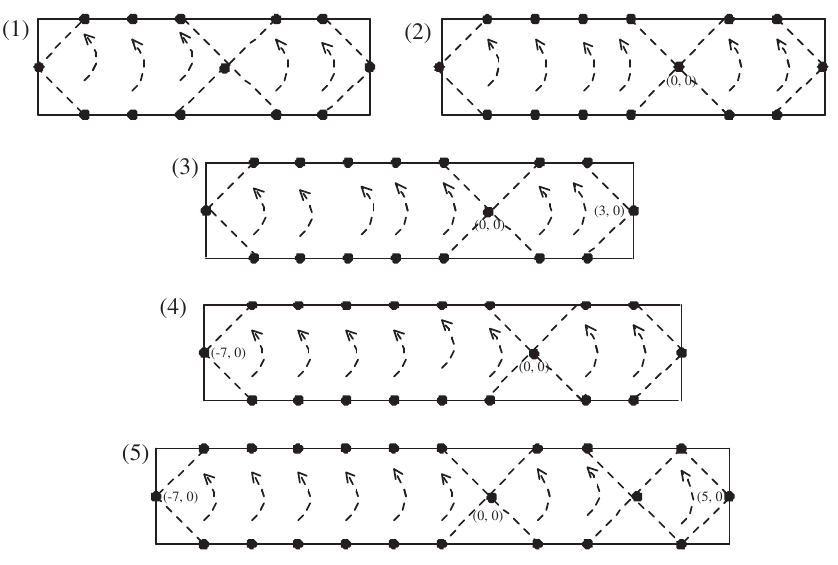
Figure 3. In these figures, the dotted arrows indicate 8-continuous self-mappings. (1)–(4) Explanation ∨ C n ,6 ) , l ∈ { 8,10,12,14 } ; (5) Explanation of the perfectness of of being two components of F ( C n , l k k ∨ C n ,6 ∨ C n ,4 ) = [ 0, l + 8 ] Z , l ∈ { 4,6,8,10,12,14,16, 18,20 } (see Theorem 7). In particular, l = F ( C n , l k k k